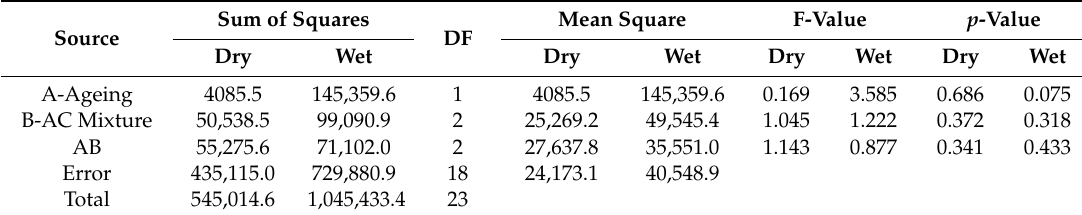
Table 2. Two-way ANOVA with interaction